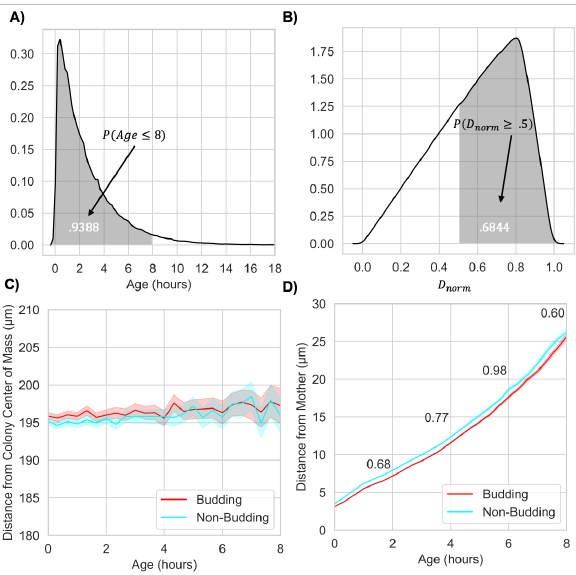
Figure 4. Age and Spatial Organization of Cells in Nutrient-Rich Colonies. ( A ) Empirical probability density function for cell ages in synthetic colonies after 24 h of colony growth. We observe that the probability that a given cell is ≤ 8 h old is 0.9388; ( B ) Empirical probability density function for the normalized distance from the colony center of mass to the birth location of cells born in the last hour of colony growth ( D norm ). We observe that the probability that D norm is ≥ 0.5 is 0.6844; ( C ) Cell age (h) versus cell distance from the colony center of mass for budding (red) and non-budding (blue) colonies at the 24 h time point. In both ( C,D ), average values were determined for different age groups using a sliding window with a fixed window size of 20 min. We conclude that cell distance from the colony center of mass is not impacted by cell age or budding division since 95% confidence intervals overlap; ( D ) Cell age (h) versus cell distance from its mother for budding (red) and non-budding (blue) colonies. The difference between budding and non-budding colonies is given for age groups 2,4,6,8. We conclude that this difference is significant since 95% confidence intervals do not overlap. (See Section 2.1.2 for